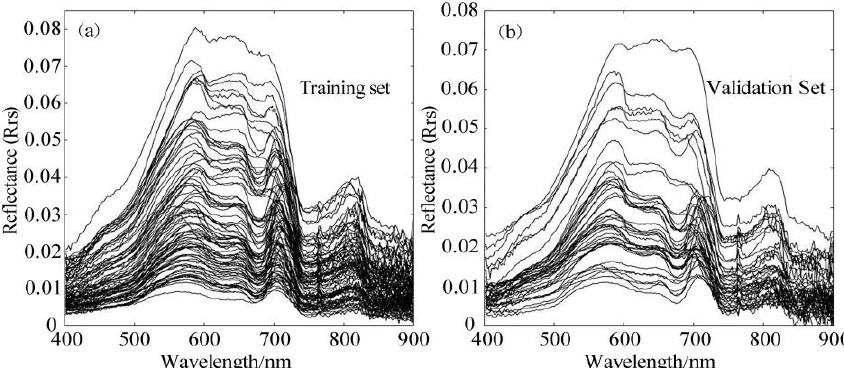
Figure 2. Spectral reflectance. ( a ) The training samples (N = 90) and ( b ) the validation samples (N = 45).